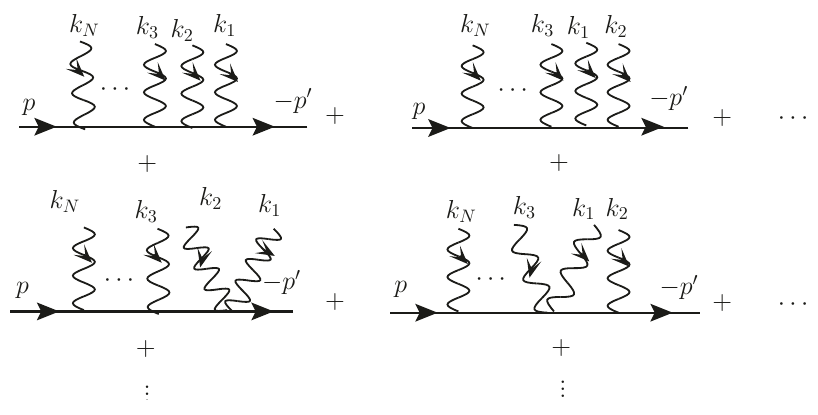
Figure 2 . Multi-photon Compton scattering diagram in scalar QED (we do not distinguish the propagator of the matter (cid:12)eld between scalar or spinor QED, choosing to indicate both with a solid line). The seagull vertices in the second row are once again produced by the (cid:14) -function in the second derivative of the open-line Green function